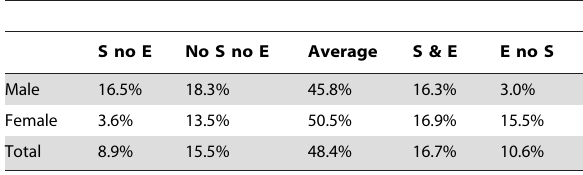
Table 3. The proportion of males and females by the classification scheme shown in the left panel of Figure